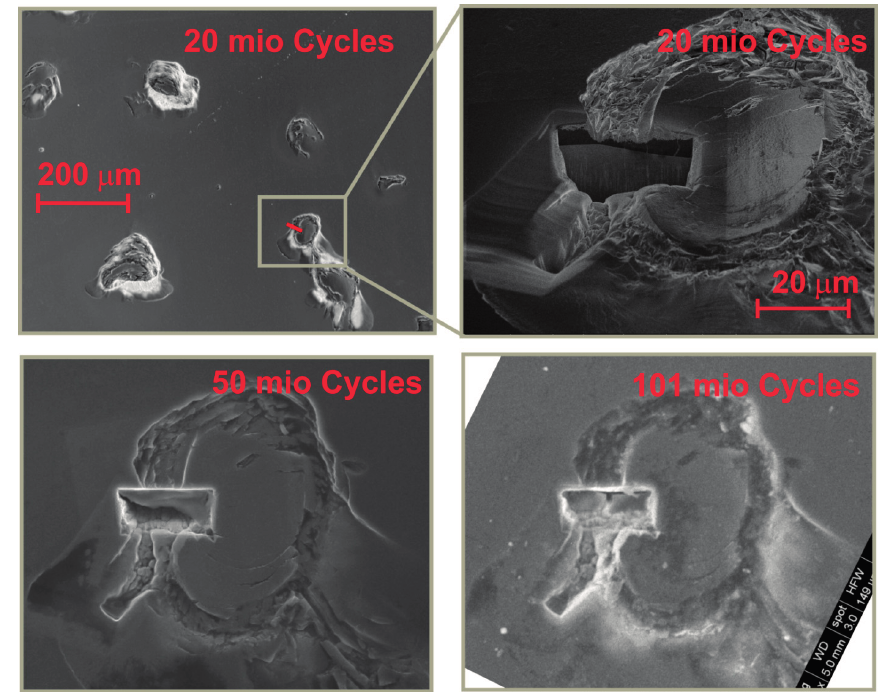
Figure 4. Defect evolution on a selected defect site after 20, 50 and 100 million cycles.